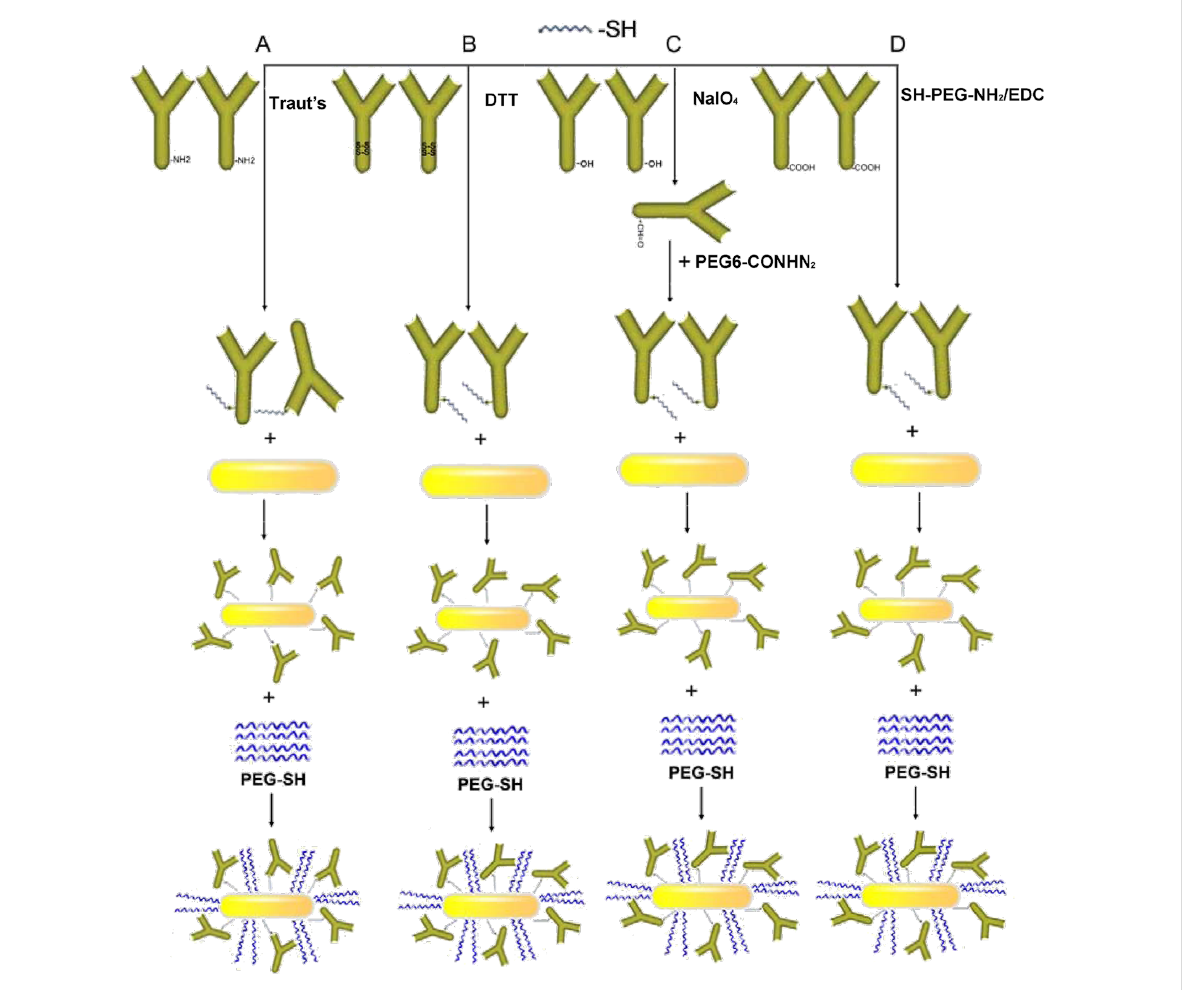
Figure 1: Schematic of the conjugation of GNRs and anti-IgG. Thiol groups were introduced to anti-IgG by Traut’s reagent (A), DTT (B), PEG6- CONHNH 2 (C), and SH-PEG-NH 2 combined with EDC reaction (D) and then conjugated with GNRs through an Au–S bond, followed by the addition of PEG-SH to stabilize the conjugation.